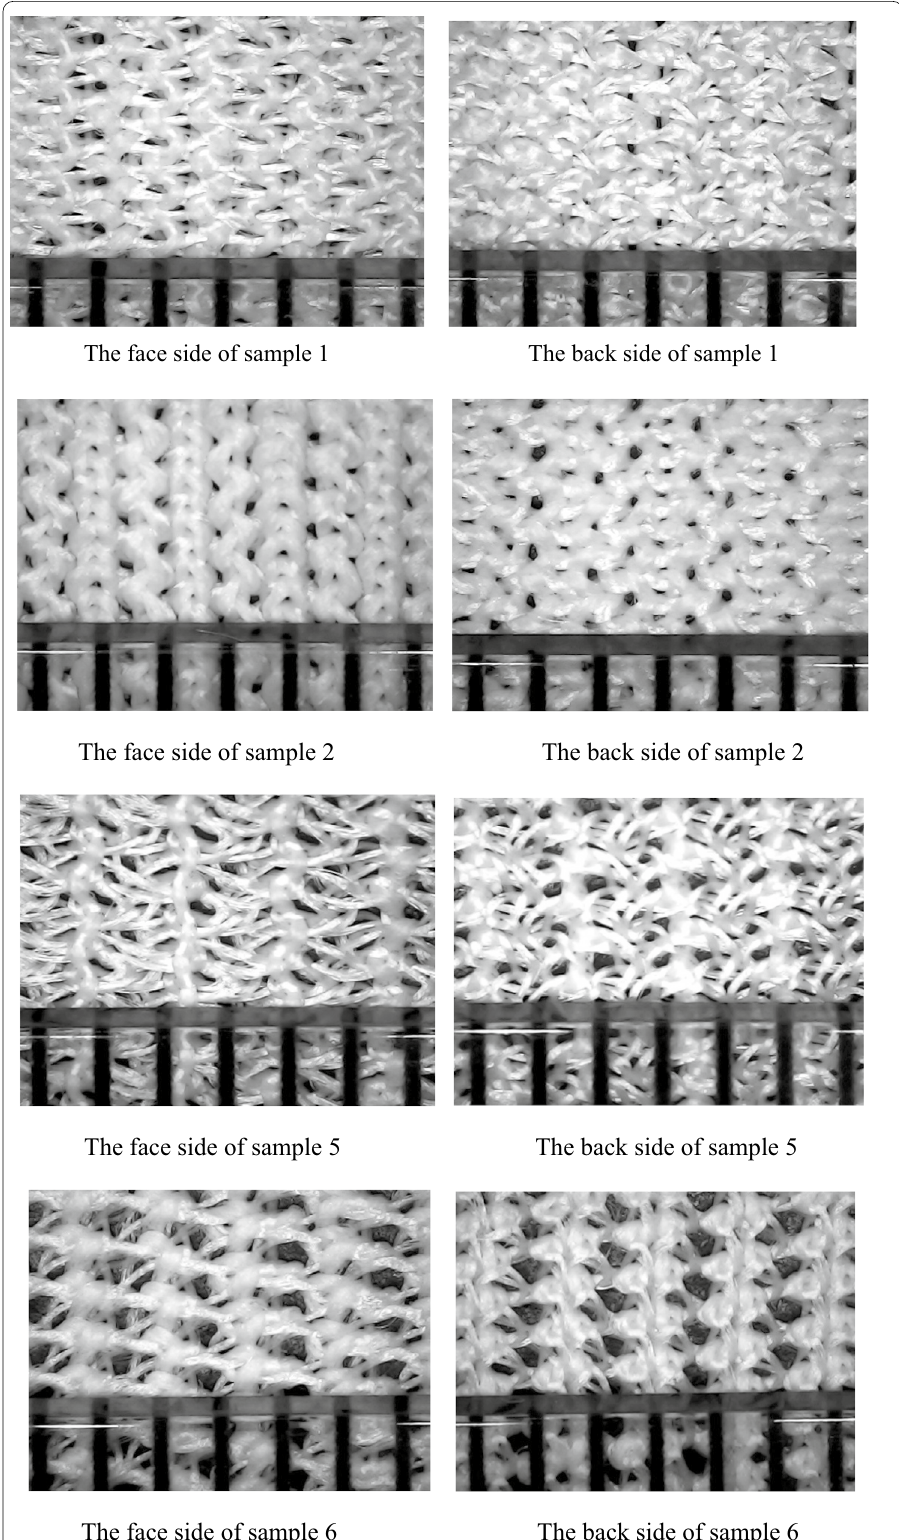
Fig. 2 The photos of samples 1, 2, 5 and